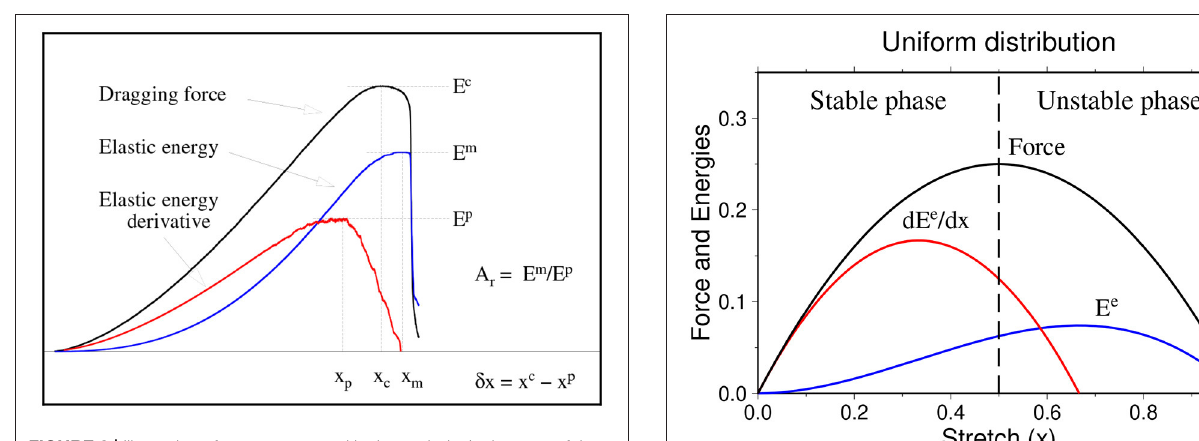
FIGURE 2 | Illustration of parameters used in the analysis. In the case of the DEM analysis, the vertical deformation (strain) parameters, x , x c , and x p , are scaled by the initial height l 0 of the tissue. FIGURE 3 | Force (black curve), elastic energy (blue curve), and elastic energy